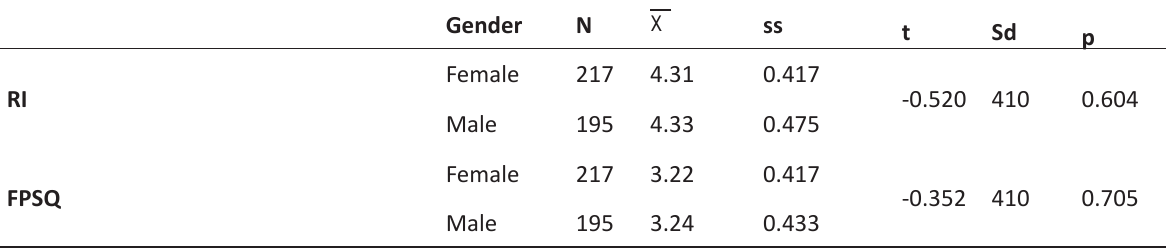
Table 5. t-Test results of the scales according to the gender